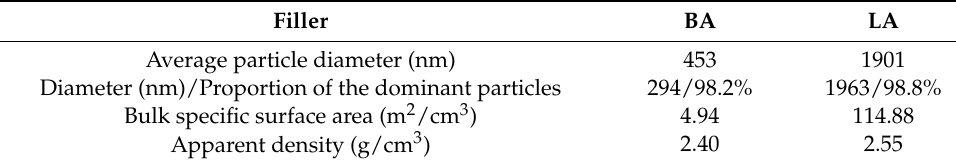
Figure 1. The volcanic ash fine filler of Bahaozha (BA) and Lazihe (LA). Table 1. Physical properties of BA and LA volcanic ashes.